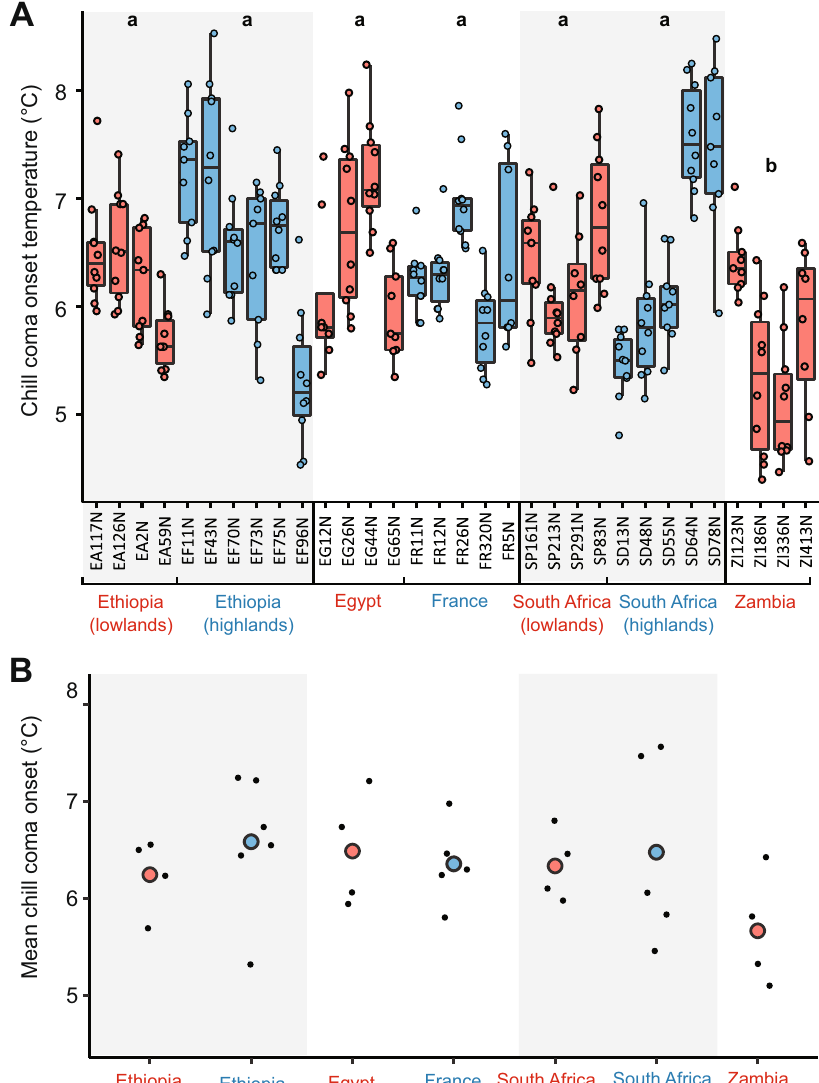
Figure 2. Chill coma onset temperatures of D. melanogaster females of all lines used. (A) All data shown. Lines in blue are from relatively cold habitats, whereas lines in red are from relatively warm habitats. The thicker line in the centre of each boxplot represents the median, and the upper and lower hinges represent first and third quartiles, respectively. Whiskers extend to 1.5 times the interquartile range, or to the smallest or largest values if they fall within 1.5 * IQR. Coloured circles represent individual flies. Populations that share a letter do not significantly differ at the population level (p < 0.05). (B) Mean CCO of each line (black circles) and overall mean of all lines from each population